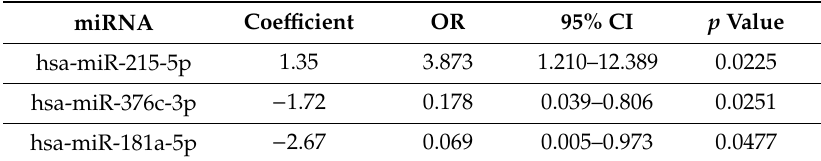
Table 4. Final multivariate regression model for predicting refractoriness to bortezomib-based treatment in MM